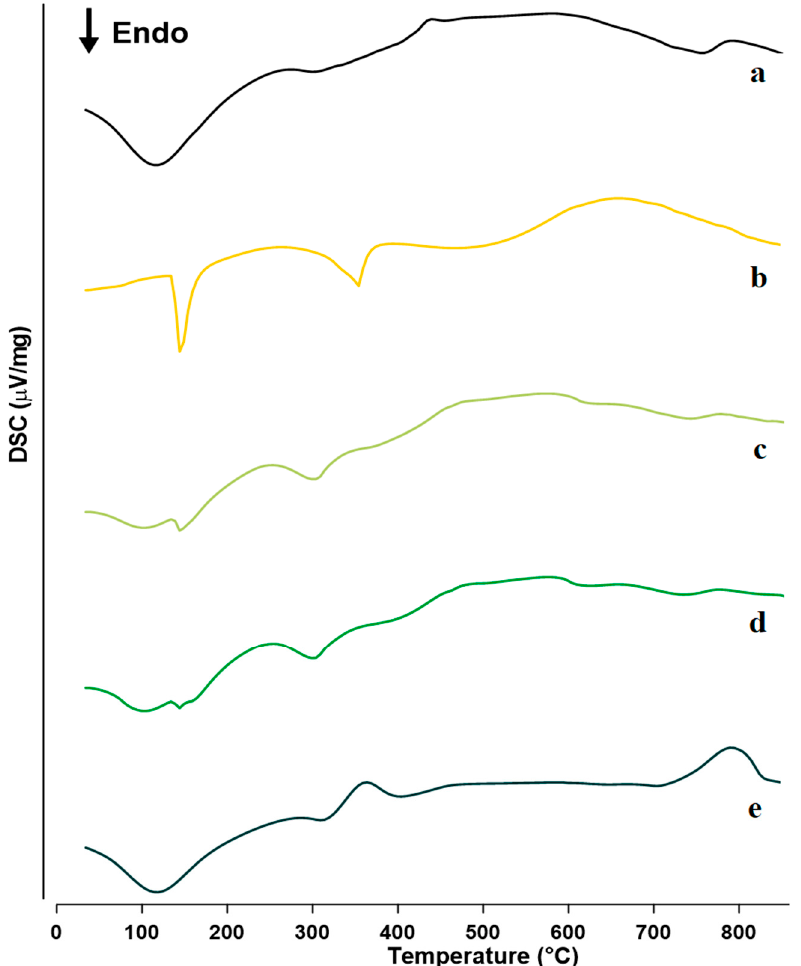
Figure 3. DSC thermograms for: ( a ) Sulfonatocalix[4]naphthalene, ( b ) fluconazole (FZ) ( c ) Physical mixture (PM), ( d ) kneaded (KN), and ( e ) co-evaporate powder (CO). The DSC thermogram of sulfonatocalix[4]naphthalene showed two major endothermic events at 108.0 °C and 750.0 °C, attributed to its dehydration and fusion or decomposition [29]; respectively. The results showing the decreased intensity of the endothermic melting point peak of FZ and shifted to the lower temperature around 137.9 ◦ C and 137.0 ◦ C, respectively, were revealed through thermograms of the physical and kneaded powder products of the drug host. This result could be due to the lowering of FZ crystallinity due to mixing with amorphous sulfonatocalix[4]naphthalene, and the formation of a partial inclusion complex or the presence of FZ is an ultrafine crystallite